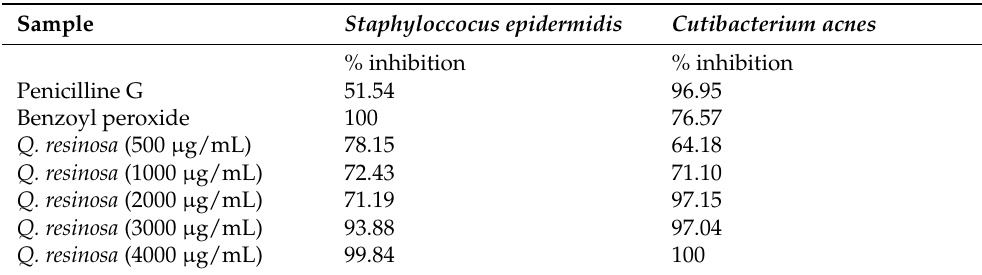
Table 3. Effect of concentration of aqueous extract of Quercus resinosa on Staphyloccocus epidermidis and Cutibacterium acnes